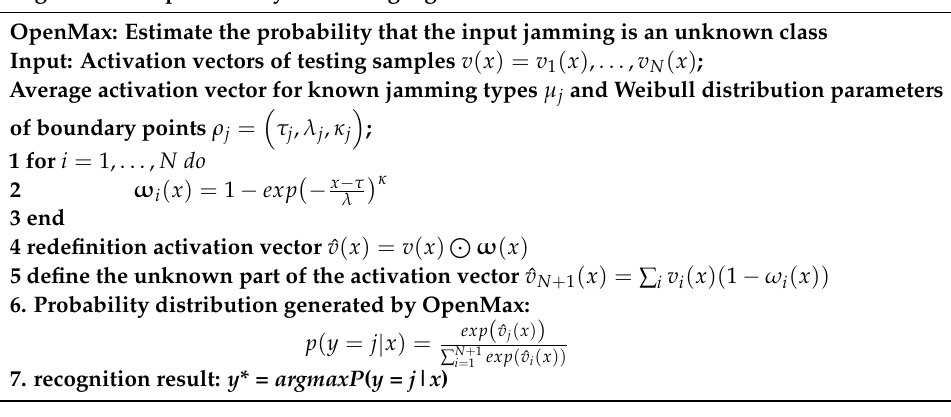
Algorithm 1. OpenMax layer building